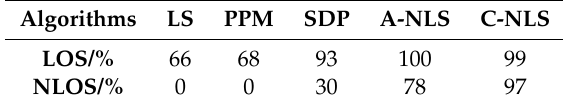
Table 5. Convergence probability in the cooperative